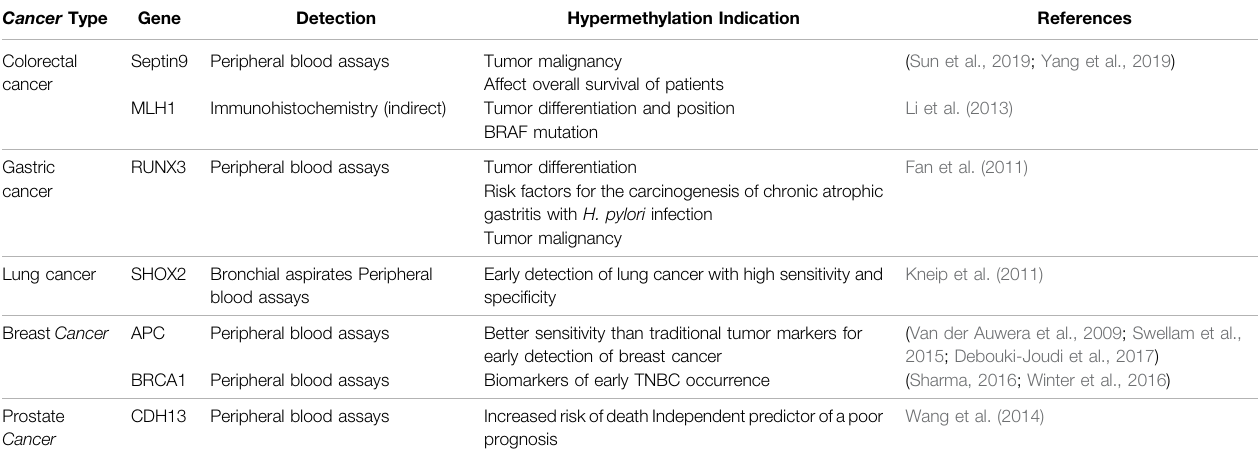
TABLE 1 | Promoter hypermethylated genes in cancers.